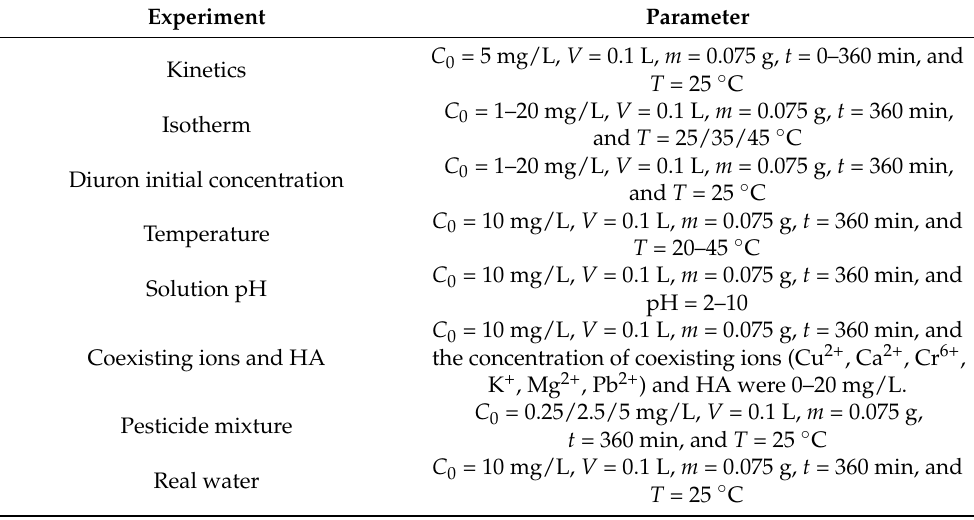
Table 3. Specific experimental parameters of SDMBC600 adsorption of